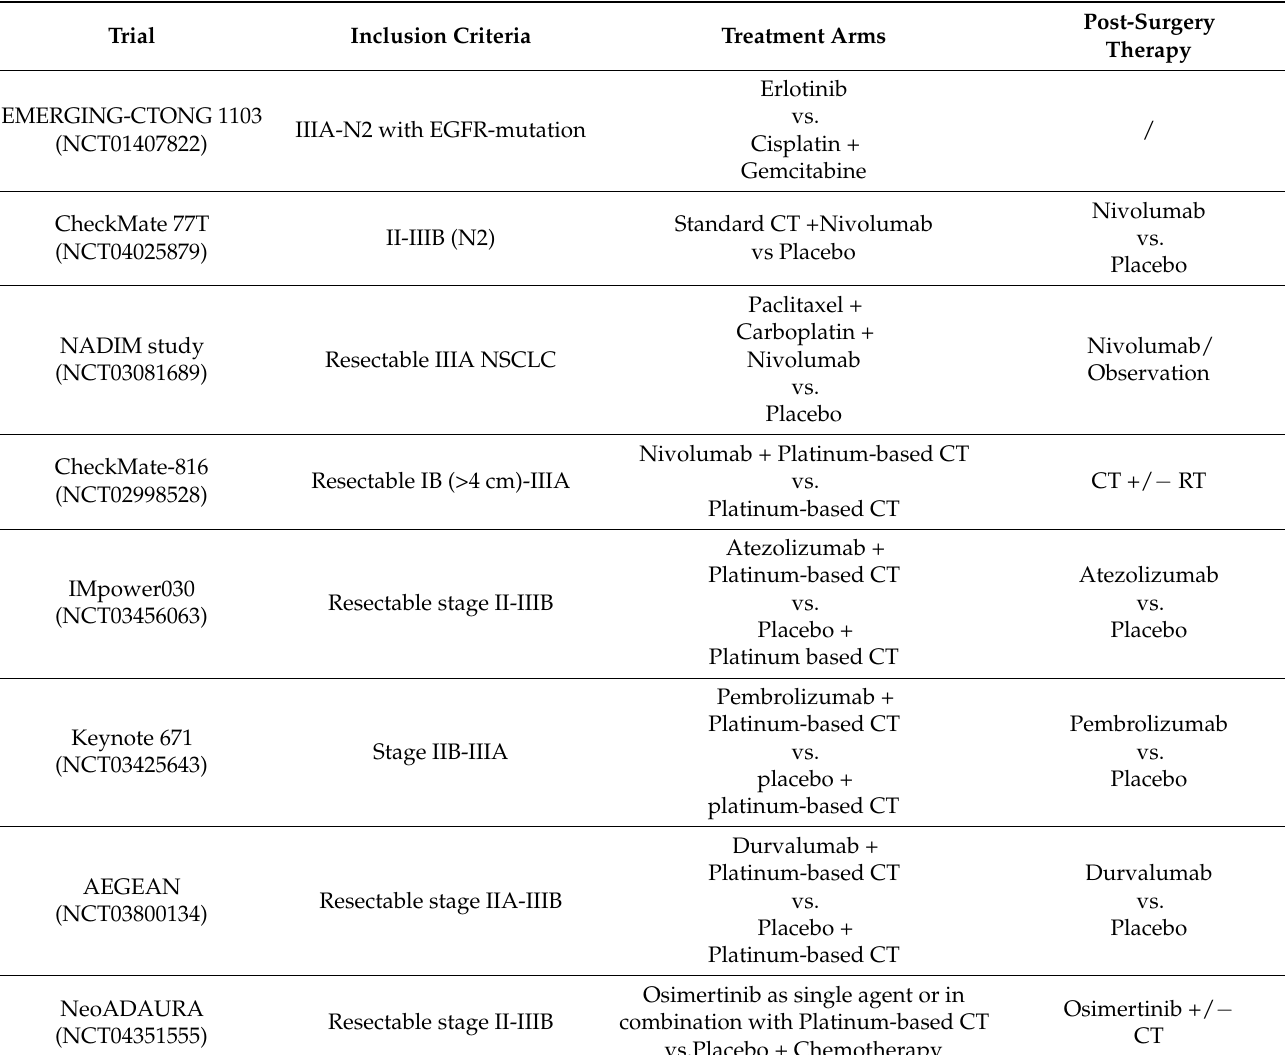
Table 1. Neoadjuvant immunotherapy/target therapy